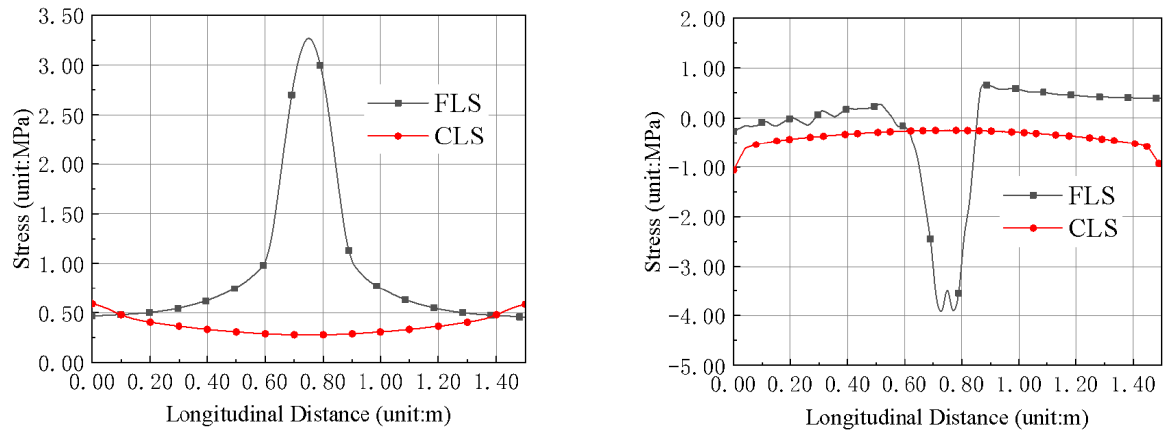
Figure 11. Stress distribution on link-slab under global warming.